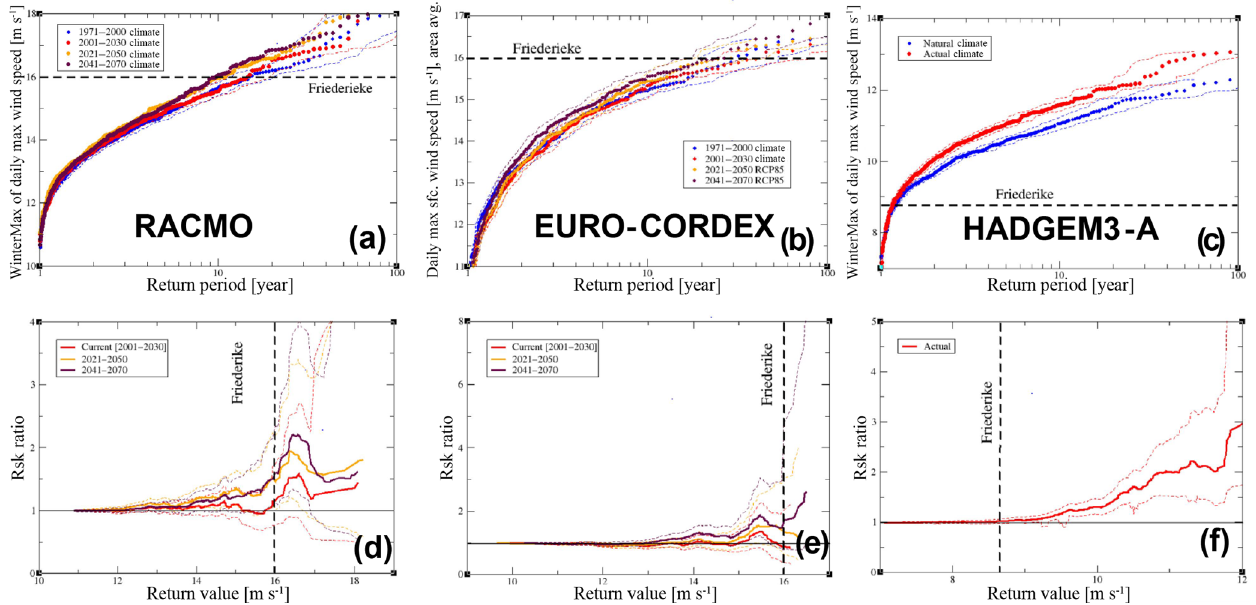
Figure 5. (a–c) Return values as a function of return periods for the storm Friederike indicator, for different time periods and the RACMO (a) , EURO-CORDEX (b) , and HadGEM3-A (c) ensembles. (d–f) Probability ratio of exceeding the return value of the indicator as compared with the counterfactual period as a function of the return value, with 5%–95% significance intervals as dashed lines with corresponding colour, calculated from a nonparametric bootstrap and shown for RACMO (d) , EURO-CORDEX (e) and HadGEM3-A (f) ensembles. Table 2. Event return periods and probability ratios summarized for all model ensembles and for storm Friederike. Probability ratios (PRs) are calculated with respect to a past or counterfactual period. PI is pre-industrial and n/a is not applicable. Ensemble Ret. period (year) PR for current PR for period PR for period PR for period PR for period climate 2021–2050 2041–2070 PI + 1 . 5 ◦ C PI + 2 . 0 ◦ C Obs. ISD-Lite 12.5 [8–400] 1/4 [1 / 100–1] n/a n/a n/a n/a Models using wind speed daily maximum (over three-hourly data) RACMO 15 [11–20] EURO-CORDEX 40 [25–80] 0.9 [0.4–2.0] Models using wind speed daily mean